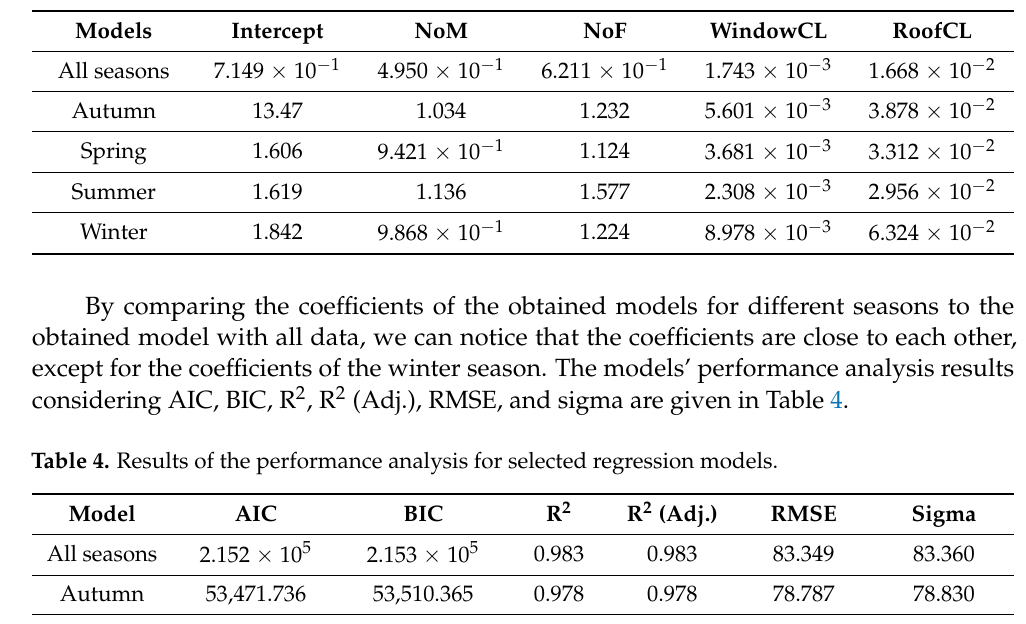
Table 3. Predictor’s coefficients for different selected models.